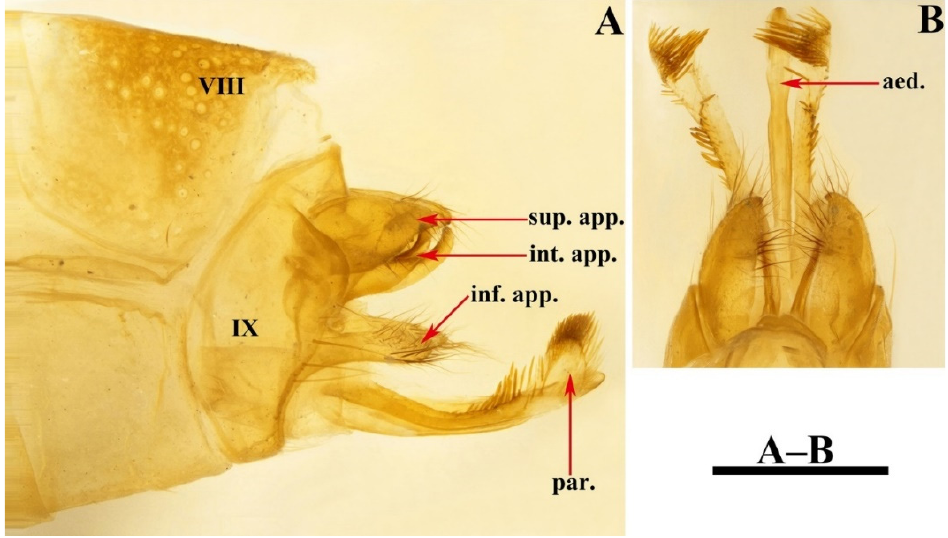
Figure 18. Limnephilus distinctus , male genitalia. ( A ) Left lateral; ( B ) dorsal. Abbreviations: sup. app. = superior appendages (paired); int. app. = intermediate appendages (paired); inf. app. = inferior appendages (paired); aed. = aedeagus; par. = paramere. Scale bar: 1 mm.